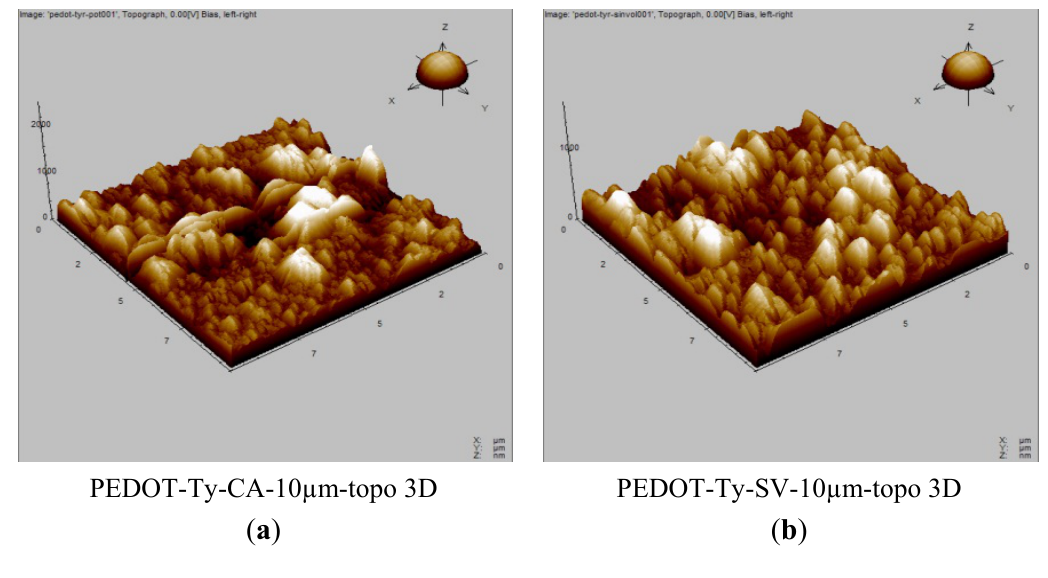
Figure 2. ( a ) 3D AFM image of PEDOT-Ty coating deposited by potentiostatic procedure (CA); ( b ) 3D AFM image of PEDOT-Ty coating deposited by sinusoidal voltage (SV) of 50 mV